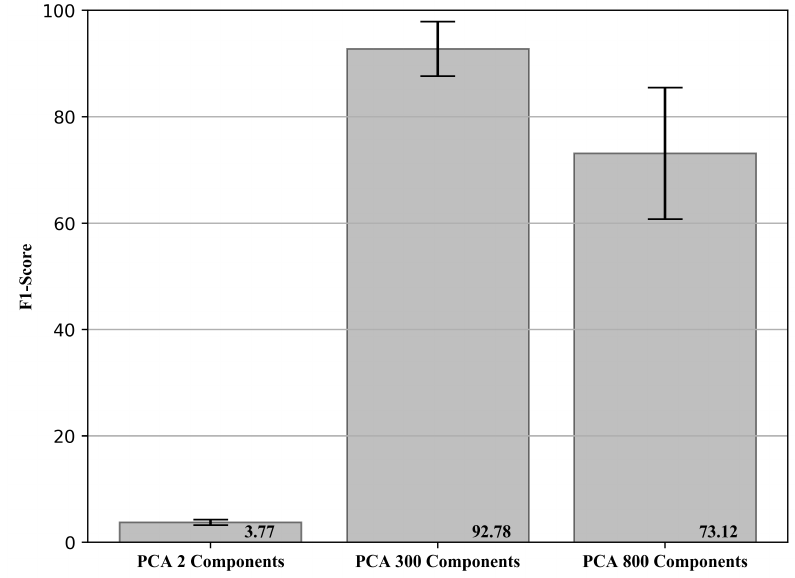
Figure 10. F1-Score and standard deviation (in percentage) obtained for PCA using the reduced features of the raw